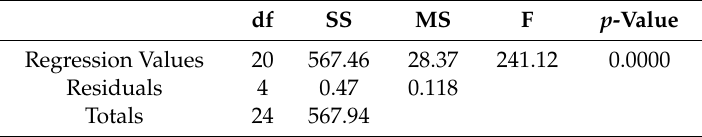
Table 3. ANOVA table for the rumor spreading model.